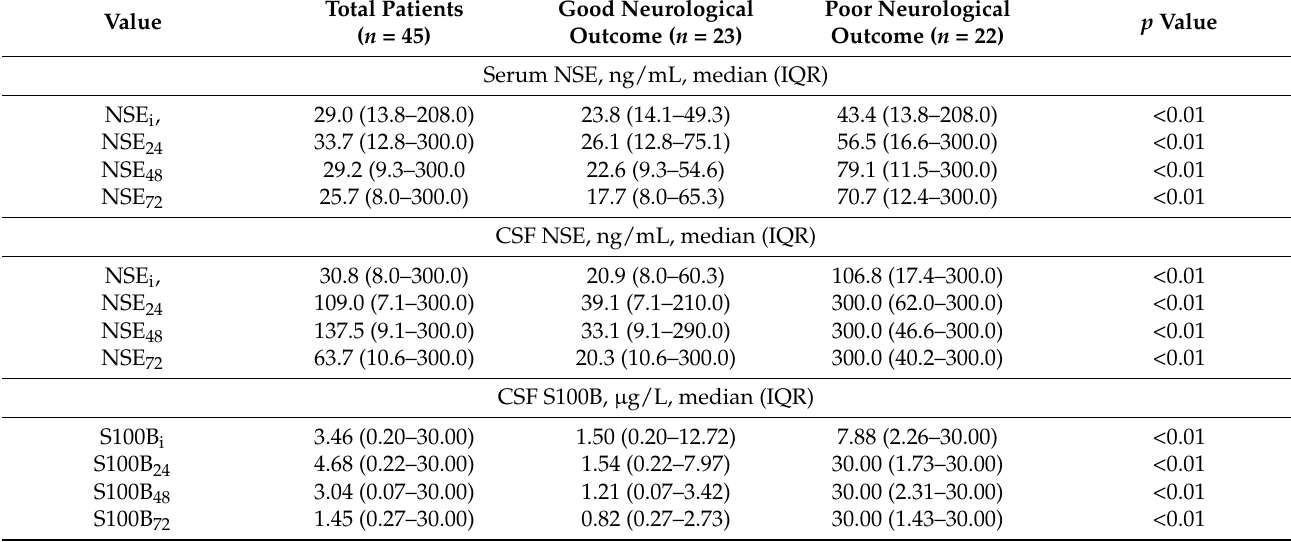
Table 2. The serum and cerebrospinal fluid concentrations of neuron-specific enolase (NSE) and S100 calcium-binding protein B (S100B) in good and poor neurological outcome